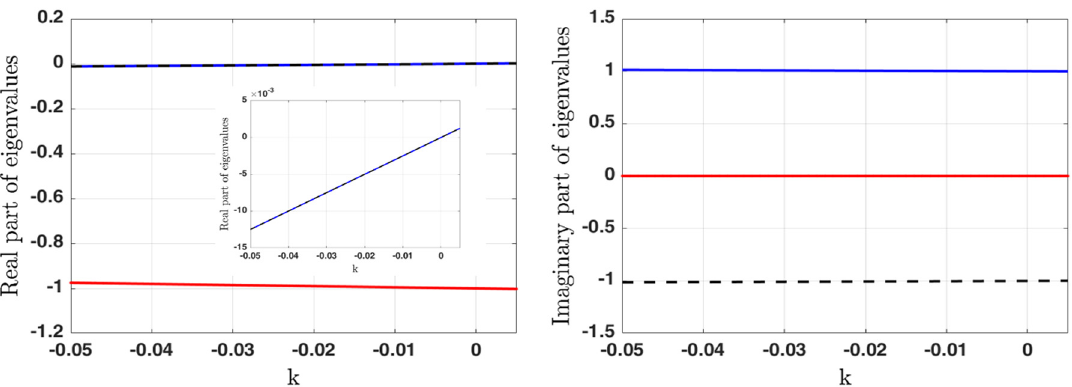
Figure 2. The real and imaginary parts of the three eigenvalues with different colors. Moreover, the zoomed view of two larger values of real parts is presented.